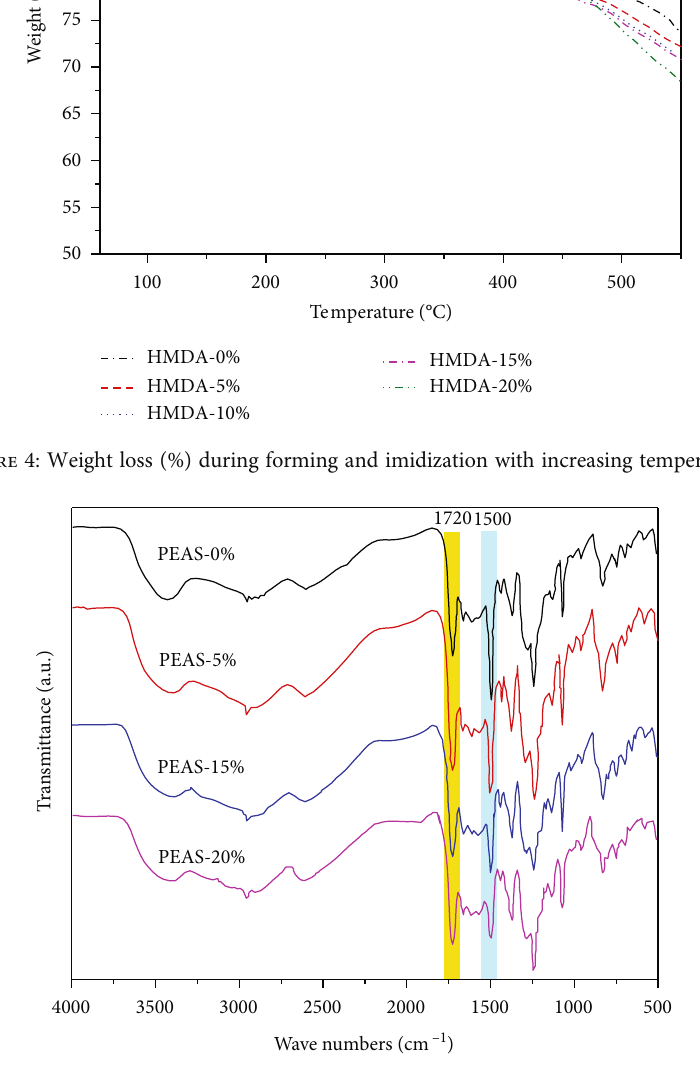
Figure 5: FTIR spectrum of PEAS with various HMDA